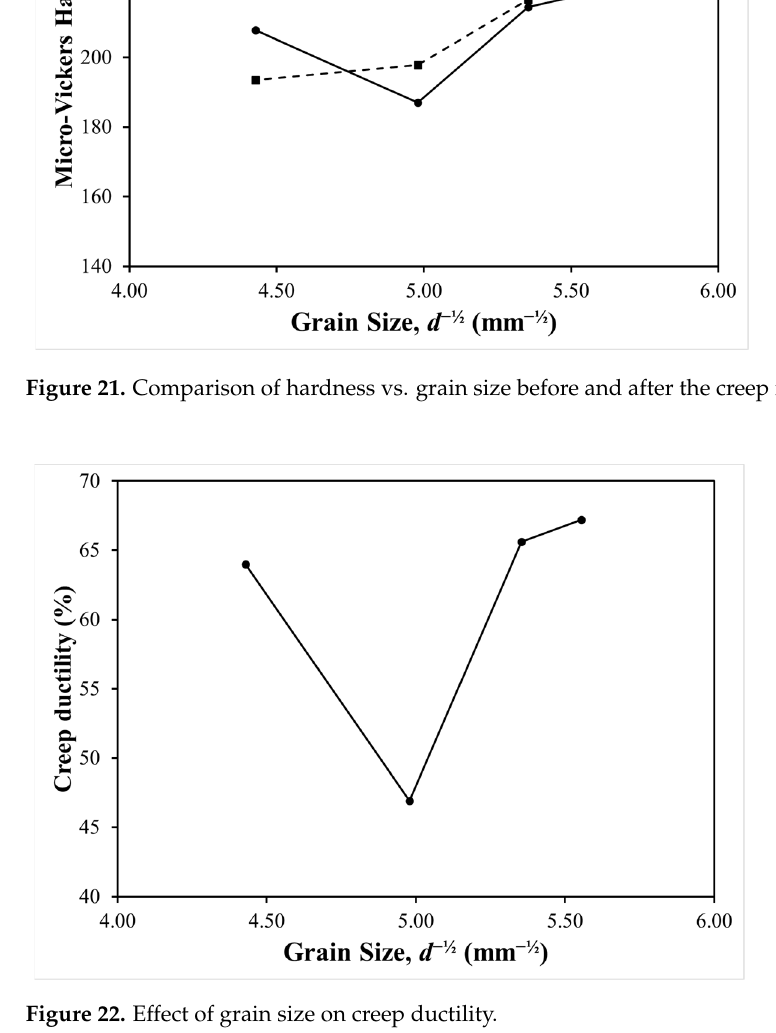
Figure 22. Effect of grain size on creep ductility.